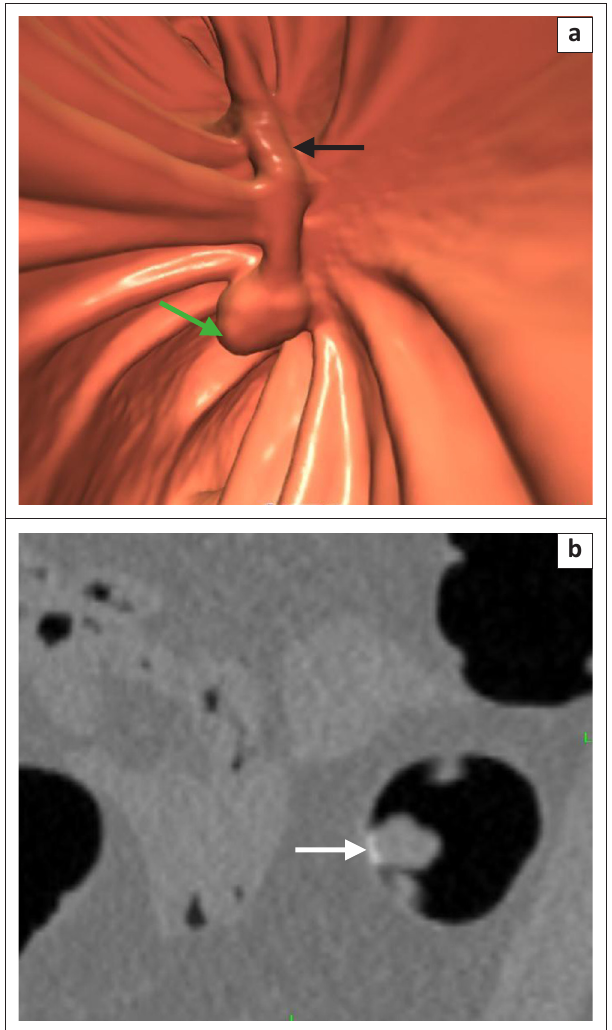
FIGURE 10. (a) Pedunculated polyp on long stalk in supine position (green arrow = head and black arrow =stalk). (b) Pedunculated polyp on medial wall